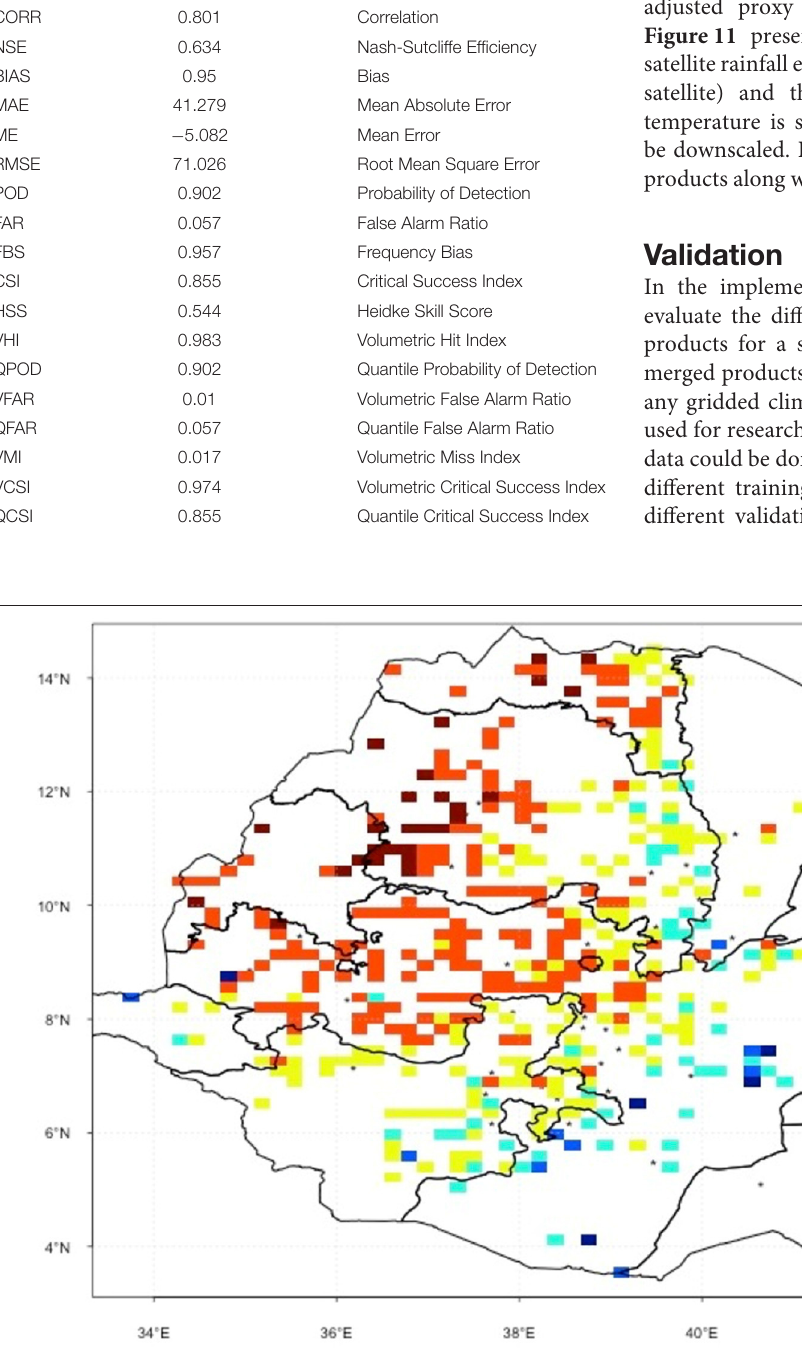
FIGURE 13 | Probability of detection for daily rainfall over